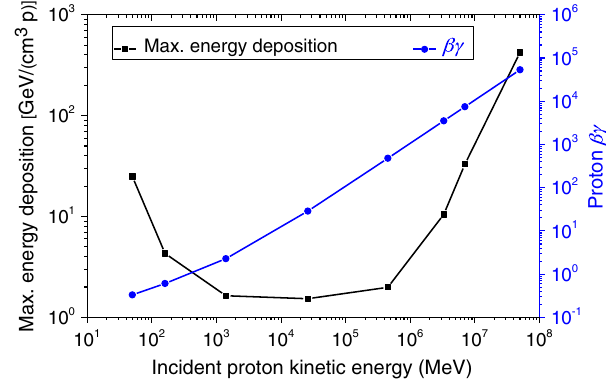
FIG. 15. Maximum energy deposition in graphite as a function of the incident proton kinetic energy. The corresponding values of βγ are plotted as well. The beam size is 0.2 mm for all the presented energies from 50 MeV to 50 TeV.